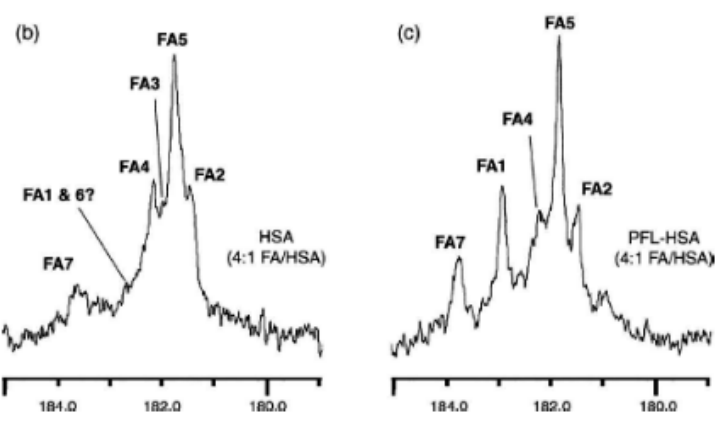
Figure 43. Correlation of the 13 C-NMR and crystal structure data for HSA. ( a ) Crystal structure of HSA complexed with palmitate. Labels indicate the FA binding sites and their assigned chemical shifts. The effects of various drugs on these chemical shifts are noted. ( b ) Spectrum of [ 13 C] palmitate